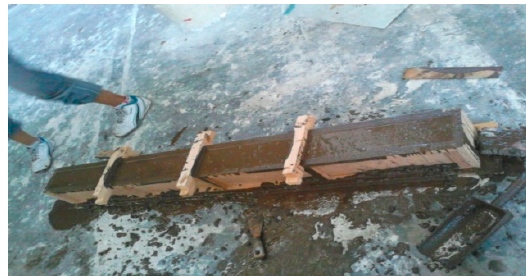
Buildings 2019 , 9 , x FOR PEER REVIEW Figure 3. The geopolymer concrete beam after casting. Figure 3. The geopolymer concrete beam after casting. Figure 3. The geopolymer concrete beam after casting.